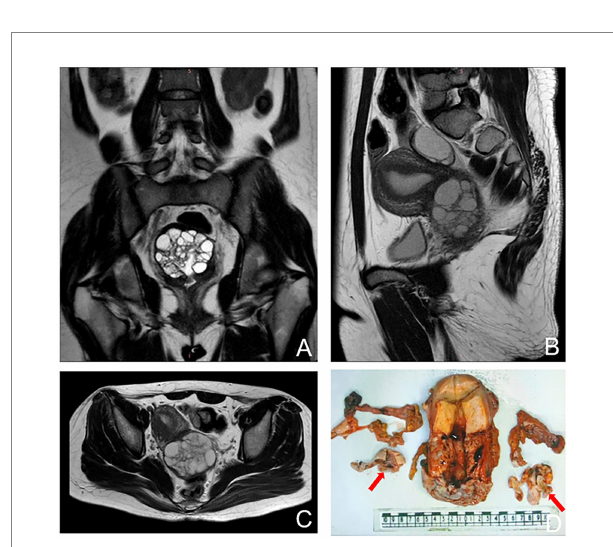
FIGURE 2 Magnetic resonance imaging (MRI) images showing an enlargement of the cervix with multiple cystic lesions. (A) coronal plane. (B) sagittal plane. (C) transverse plane. (D) Gross features of the uterus showing bulging cervix, fallopian, and ovary. The arrows show bilateral